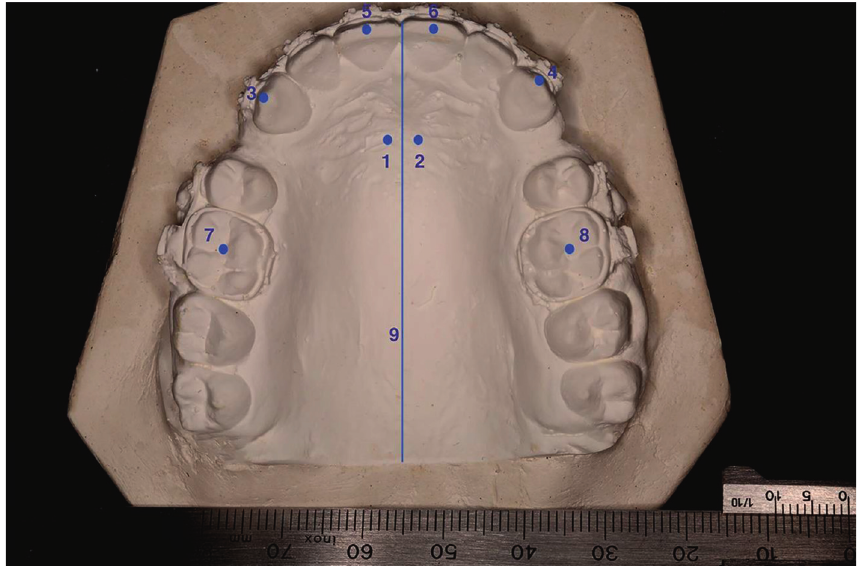
Figure 4: Landmarks used on study models. (1) The medial end of the right third palatal ruga, (2) the medial end of the left third palatal ruga, (3) the cusp of the right maxillary canine, (4) the cusp of the left maxillary canine, (5) the middle of the incisal edge of the right maxillary central incisor, (6) the middle of the incisal edge of the left maxillary central incisor, (7) the central fossa of the maxillary right first molar, (8) the central fossa of the maxillary left first molar, (9) the midpalatal suture